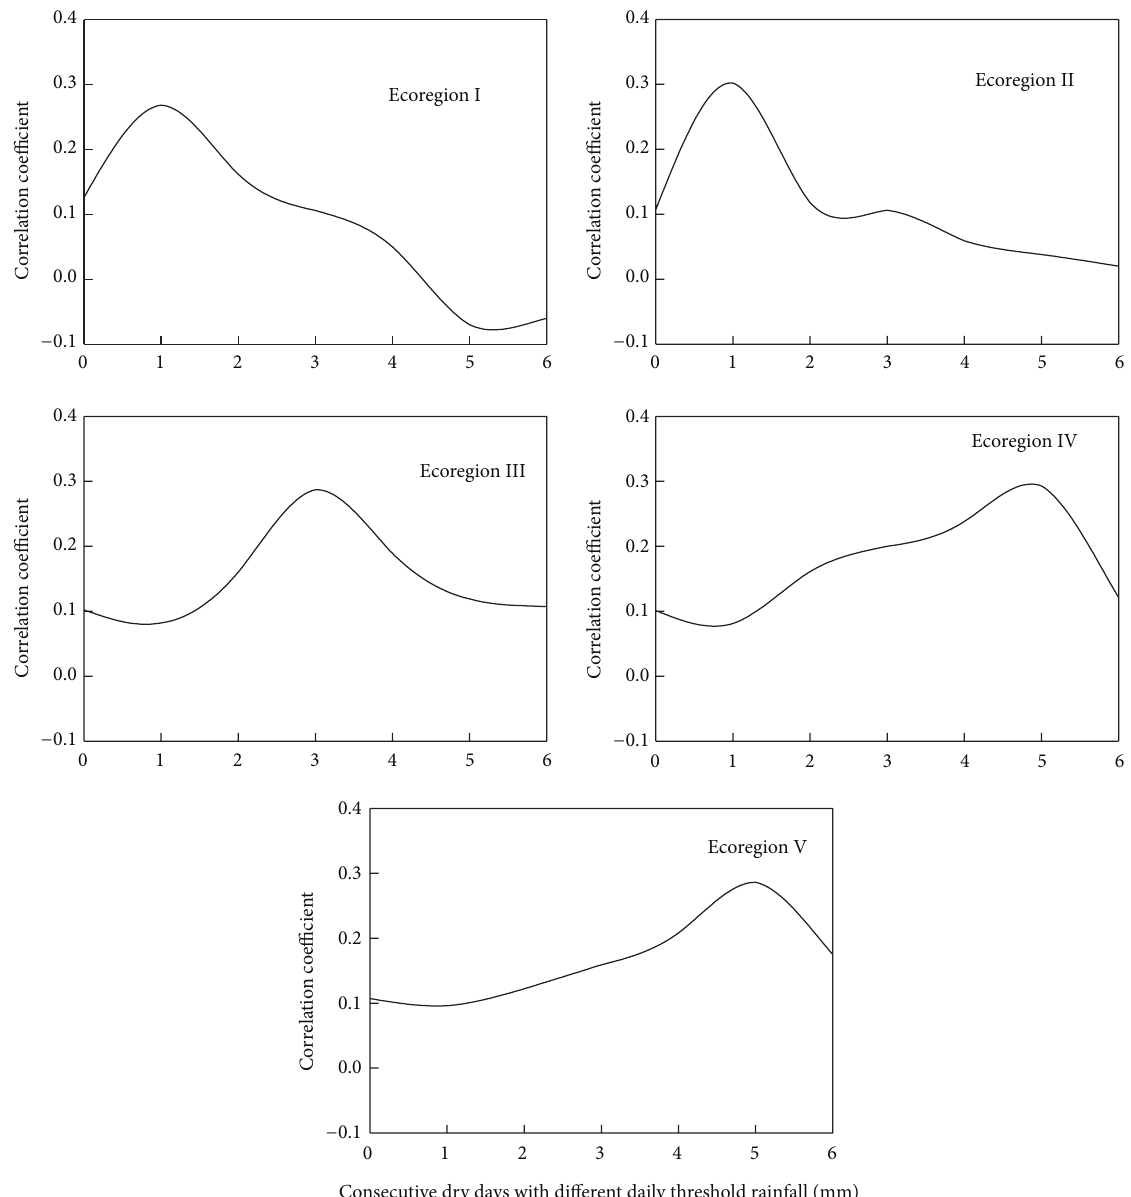
Figure 4: The change of correlation coefficients between long-transformed burned area and the number of consecutive dry days defined by the threshold daily rainfall amount (mm) by